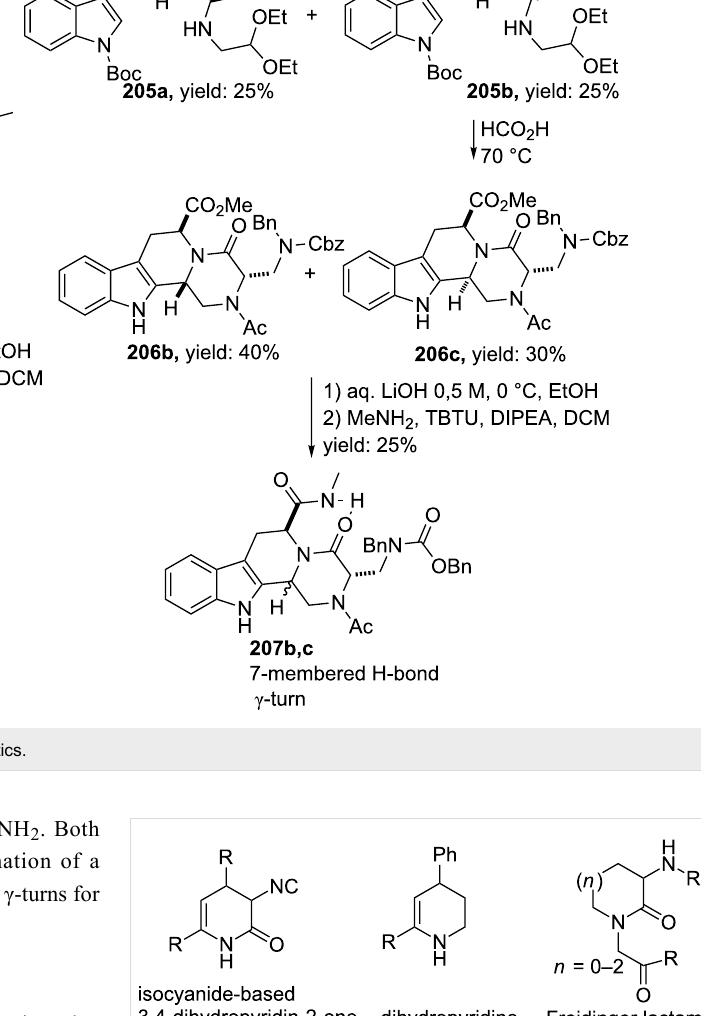
and reacts with the aldehyde, generating an in situ